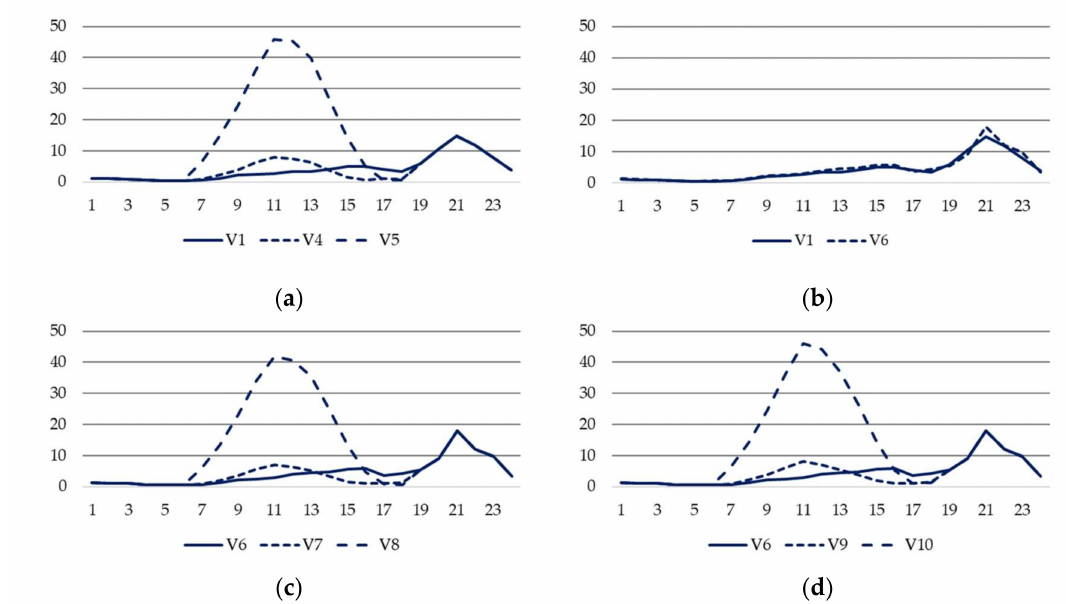
Figure A19. Daily simulation results for variants (a) V1, V4, and V5; (b) V1 and V6; (c) V6, V7, and V8; and (d) V6, V9, and V10: energy losses